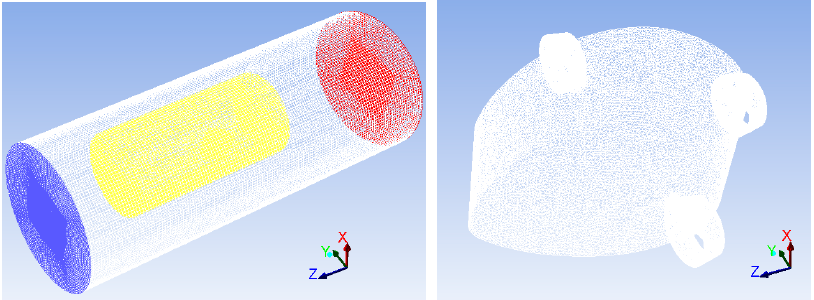
Figure 12. Computational domain meshes for the underwater robot system. ( a ) Volume mesh